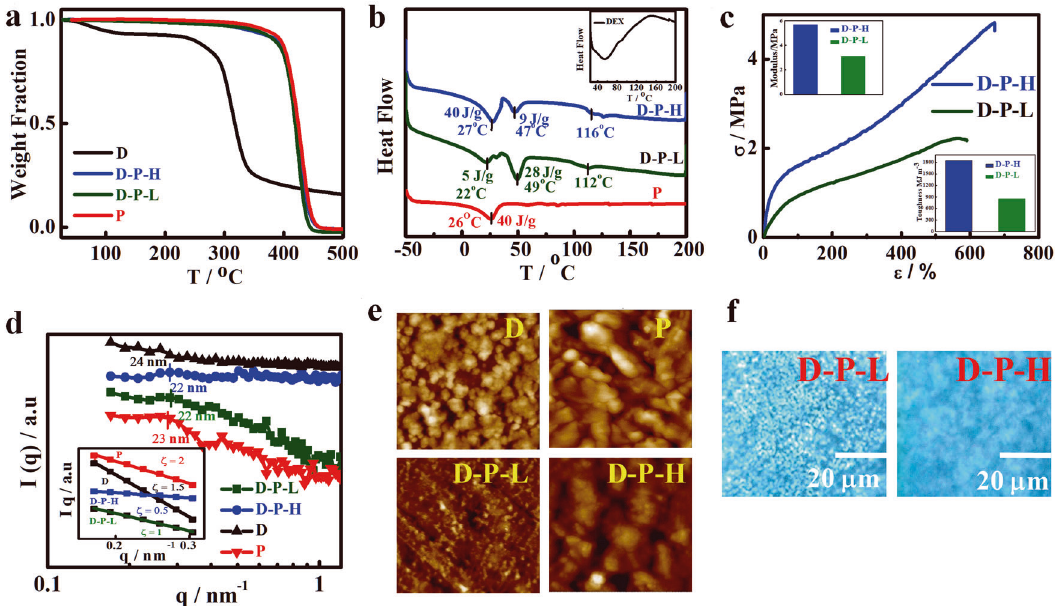
Fig. 2 Thermal, mechanical and morphological behavior of brush copolymer. a TGA thermograms of pure dextrin, prepolymer (P), and their grafts D-P-L and D-P-H showing their relative thermal stability. b DSC thermograms of P, D-P-L, and D-P-H indicating the melting temperature and heat of fusion values. The inset fi gure represents the melting pattern of pristine dextrin. c Stress – strain curves of two different brushes (D- P-L and D-P-H) showing their relative strength. Inset bar graphs indicate the modulus and toughness of the brush copolymers. d Small-angle neutron scattering pro fi le of dextrin, prepolymer, and their brushes. Debye – Bueche fi ttings of the initial data points with correlation length are provided in the inset fi gure. e AFM images of dextrin, prepolymer, and their brushes in semi-contact mode (10 × 10 μ m 2 ). f Optical images of the brush copolymers showing greater